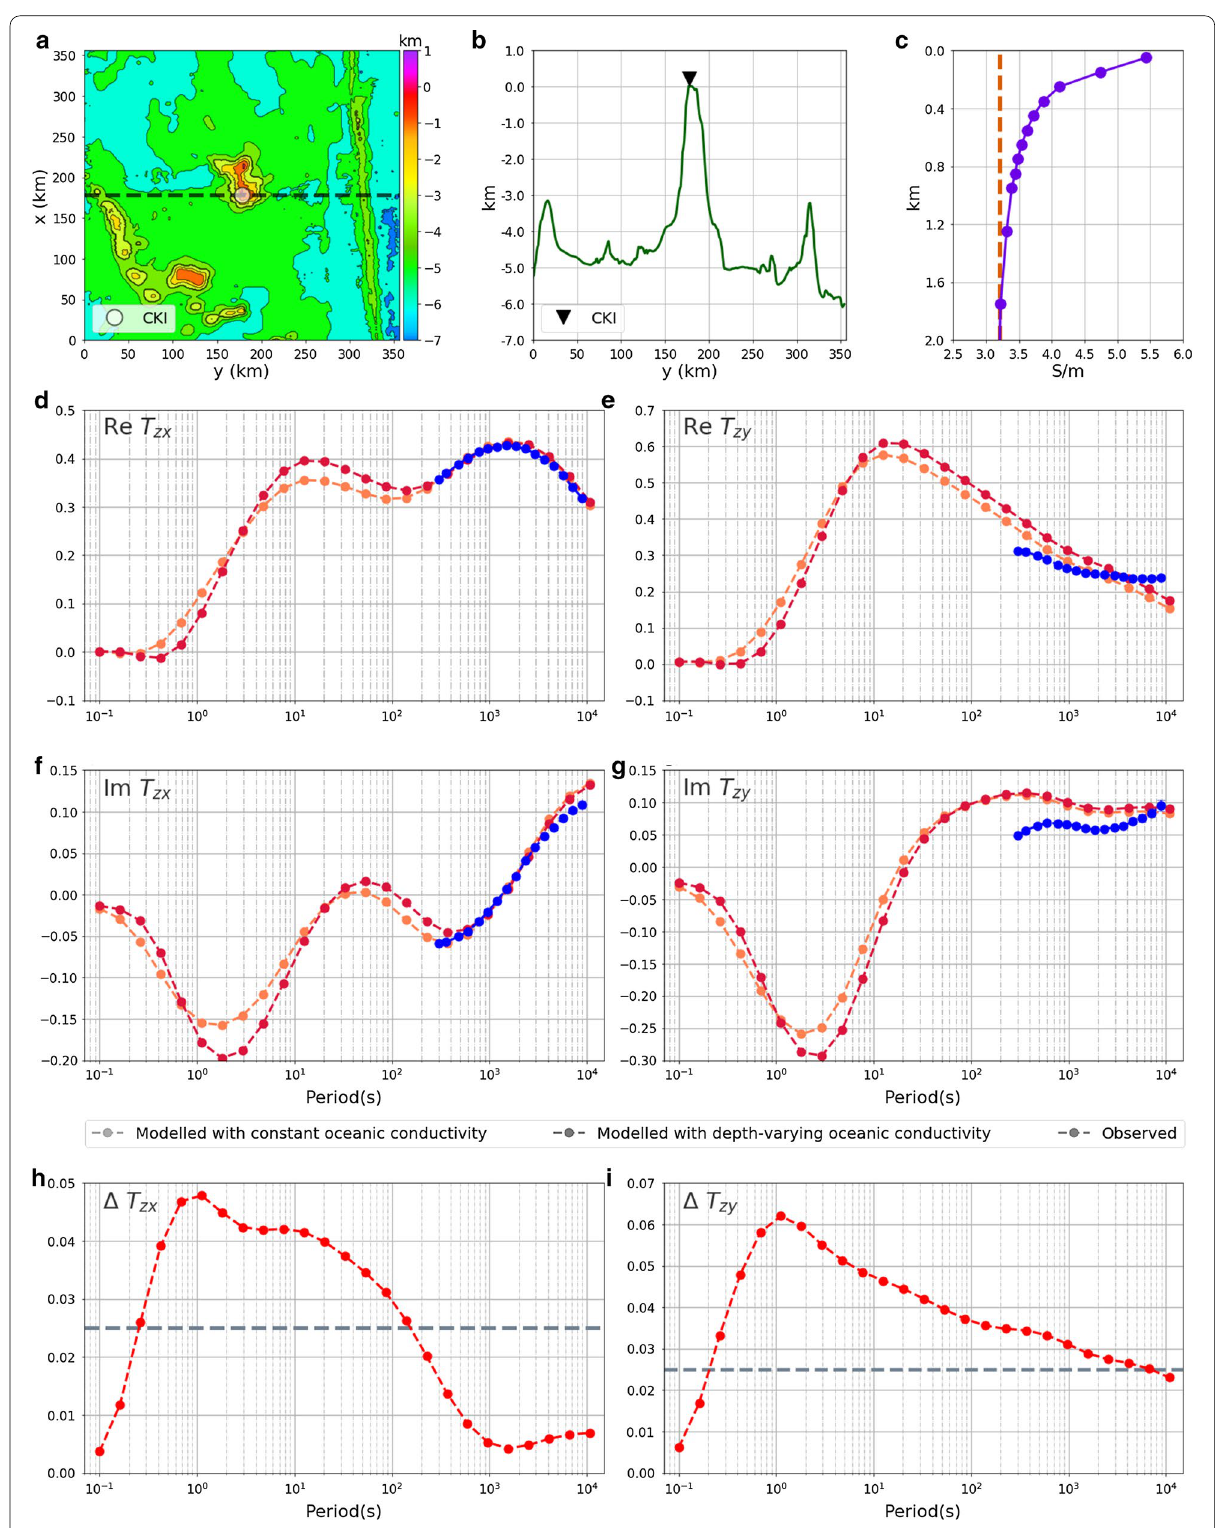
Fig. 7 Same as Fig. 5, but for Cocos-Keeling Islands observatory